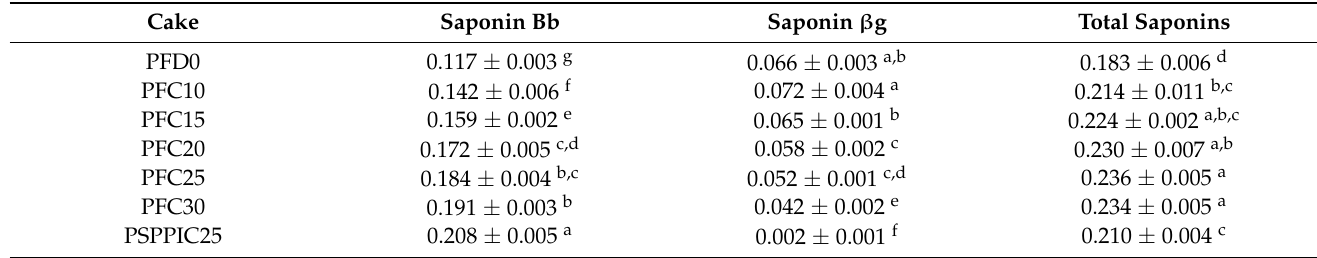
Table A3. Concentration of saponins (in mg saponin · g − 1 dry matter) extracted from the cakes. Saponin Bb, saponin β g, and total saponin concentrations are specified. Significantly different means ( p < 0.05) are represented by letters in exponent. PFD0 = pea flour unbaked dough, PFC10 = pea flour cake baked for 10 min, PFC15 = pea flour cake baked for 15 min, PFC20 = pea flour cake baked for 20 min, PFC25 = pea flour cake baked for 25 min, PFC30 = pea flour cake baked for 30 min, and PSPPIC25 = composite flour cake baked for 25 min.